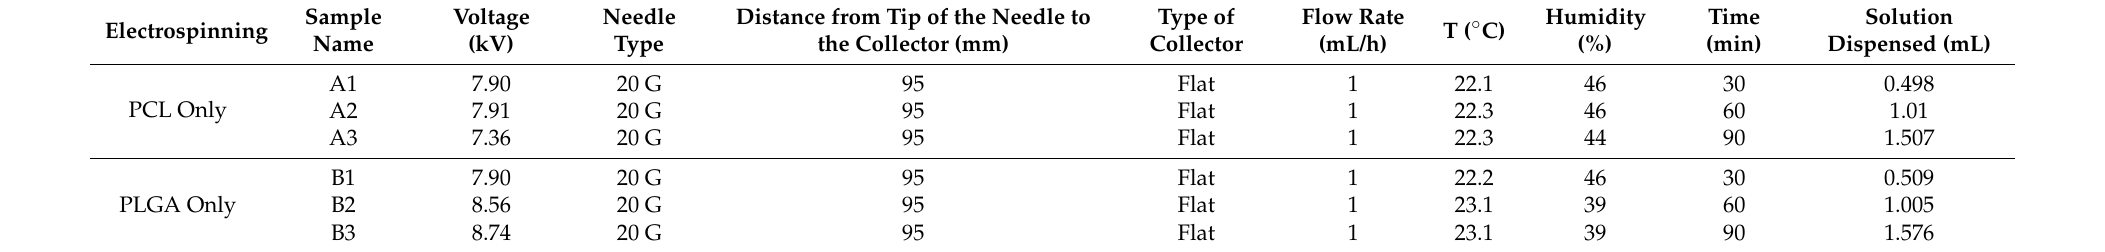
Table 1. Electrospinning process parameters that were recorded during the